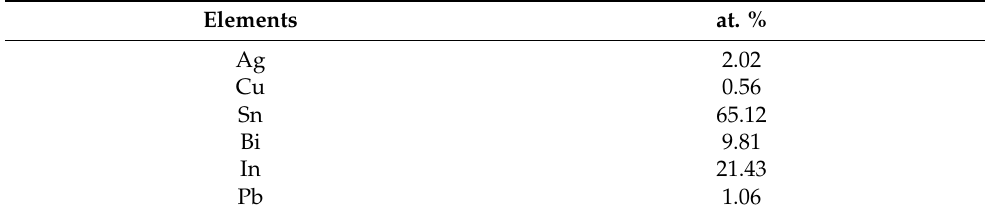
Table 1. Calculation of the atomic percentage of each element in the fully mixed solder. Elements at. %